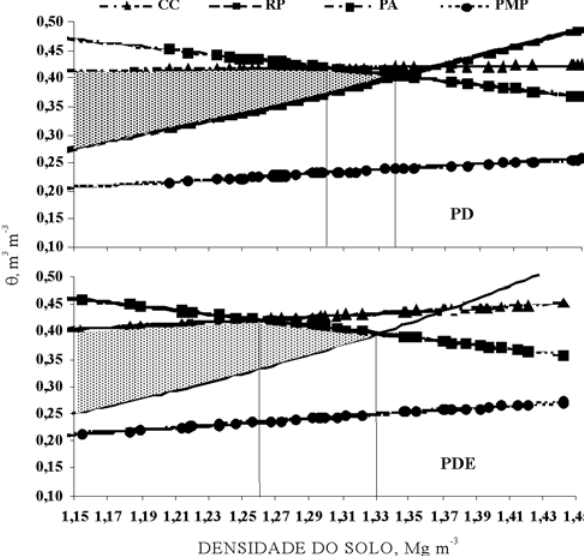
Figura 1. Variação da umidade volumétrica de acordo com a densidade do solo para os níveis críticos de capacidade de campo na tensão de 6 kPa (CC), porosidade de aeração de 10 % (PA), ponto de murcha permanente (PMP) na tensão de 1.500 kPa e resistência mecânica do solo à penetração de 2 MPa (RP). A área hachurada representa o IHO.